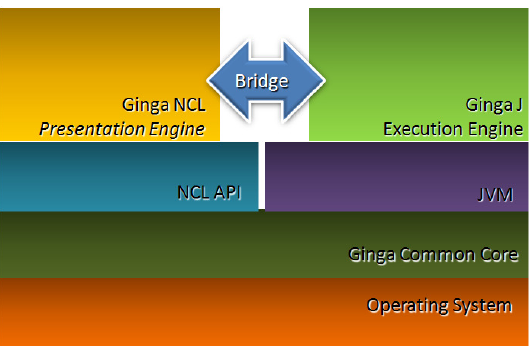
Figure 1. Architecture of the middleware Ginga.